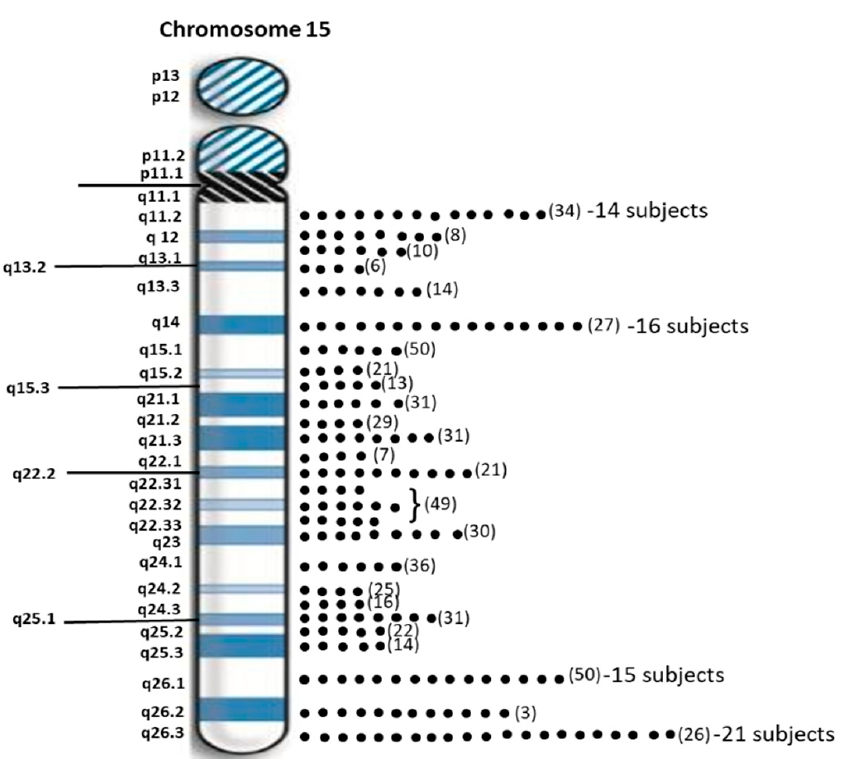
Figure 3. Distribution of chromosome 15 bands involved in segmental isodisomy 15 found by high- resolution microarray analysis and dense genotyping of chromosome 15 in our study of 154 PWS participants with maternal isodisomy 15 seen in 38 subjects. The number of protein coding genes in parentheses is noted per chromosome 15 band. The individual dots represent individual participants with that band involved in segmental or total maternal isodisomy 15. Chromosome 15q26.3 band was most often found in 21 PWS participants followed by 15q14 band in 16 participants. One of these PWS subjects (ID #19-221457) with segmental isodisomy 15 also showed mosomes 15 and X were of maternal origin (see Figure 2). Klinefelter syndrome and PWS have also been reported previously as well as trisomy X and PWS indicative of a second female meiotic error during gametogenesis involving both chromosome 15s and the sex chromosome in these individuals